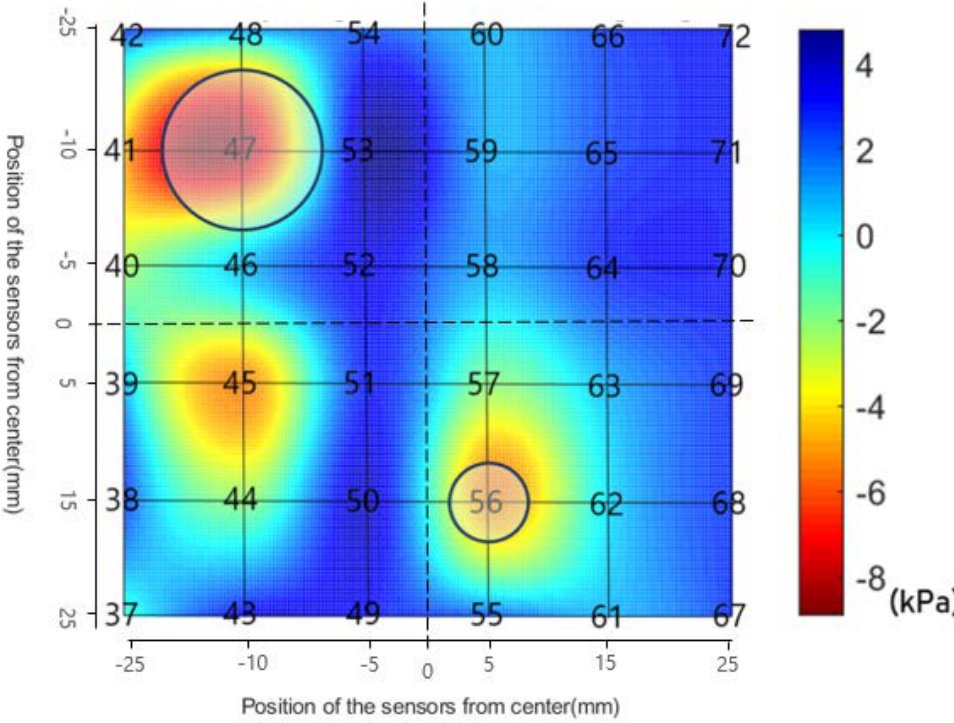
Figure 31. Contour for Discrepancy in Peak Pressure (the 10th Case Pressure -Wet Average, ROLL).